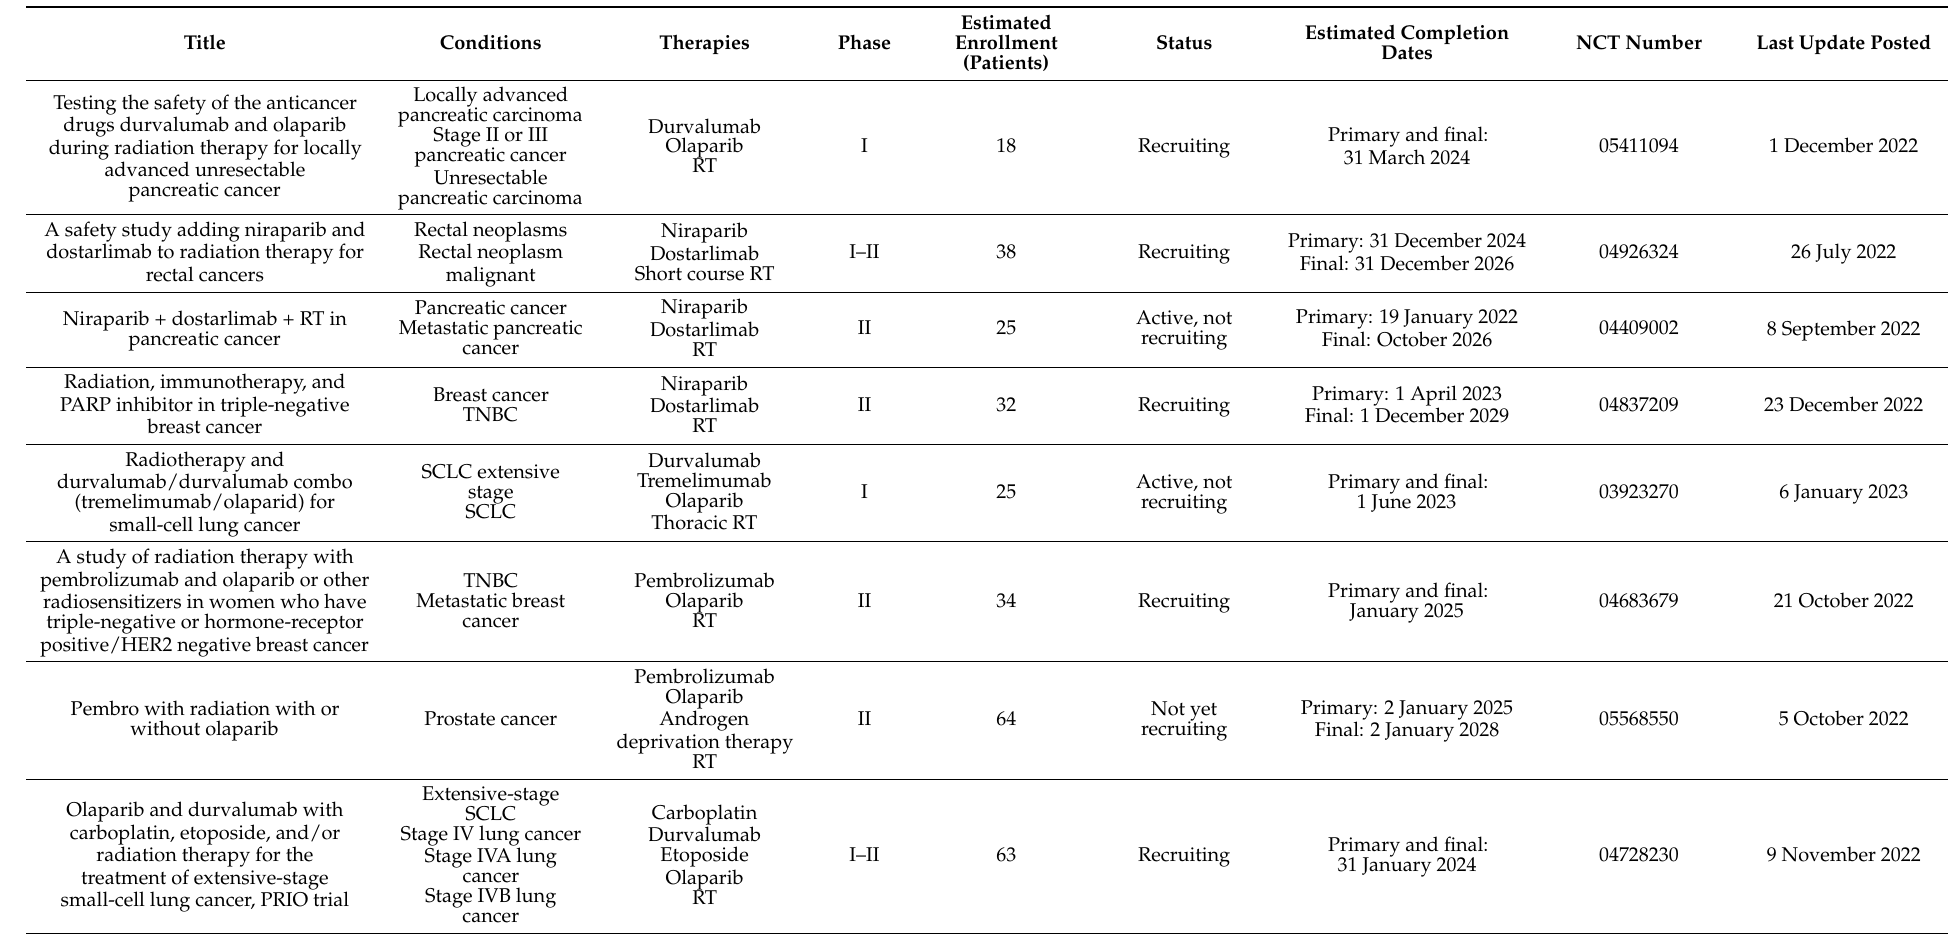
Table 1. Recently approved clinical trials using combinations of RT, PARPis, and